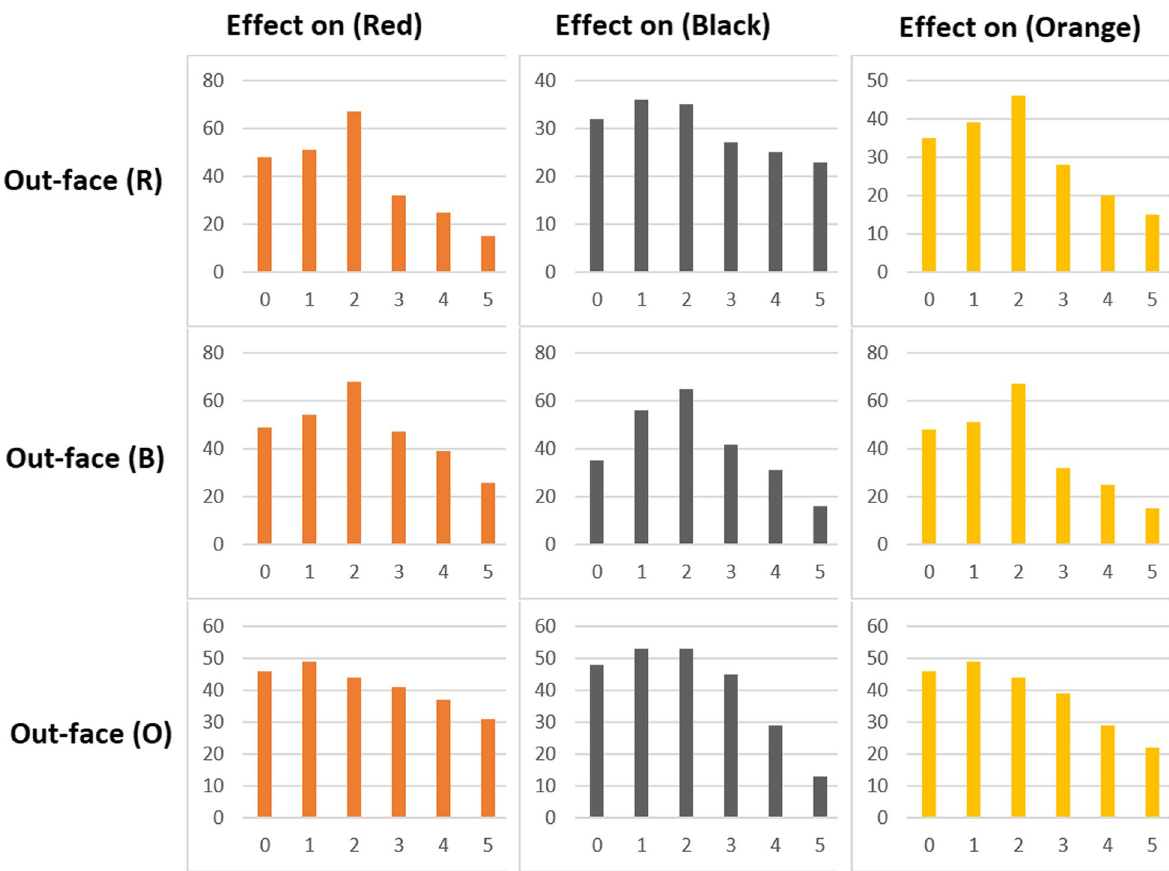
Fig. 17 Changes in bits in the container image have the same effect on all the colors in the hidden picture that was